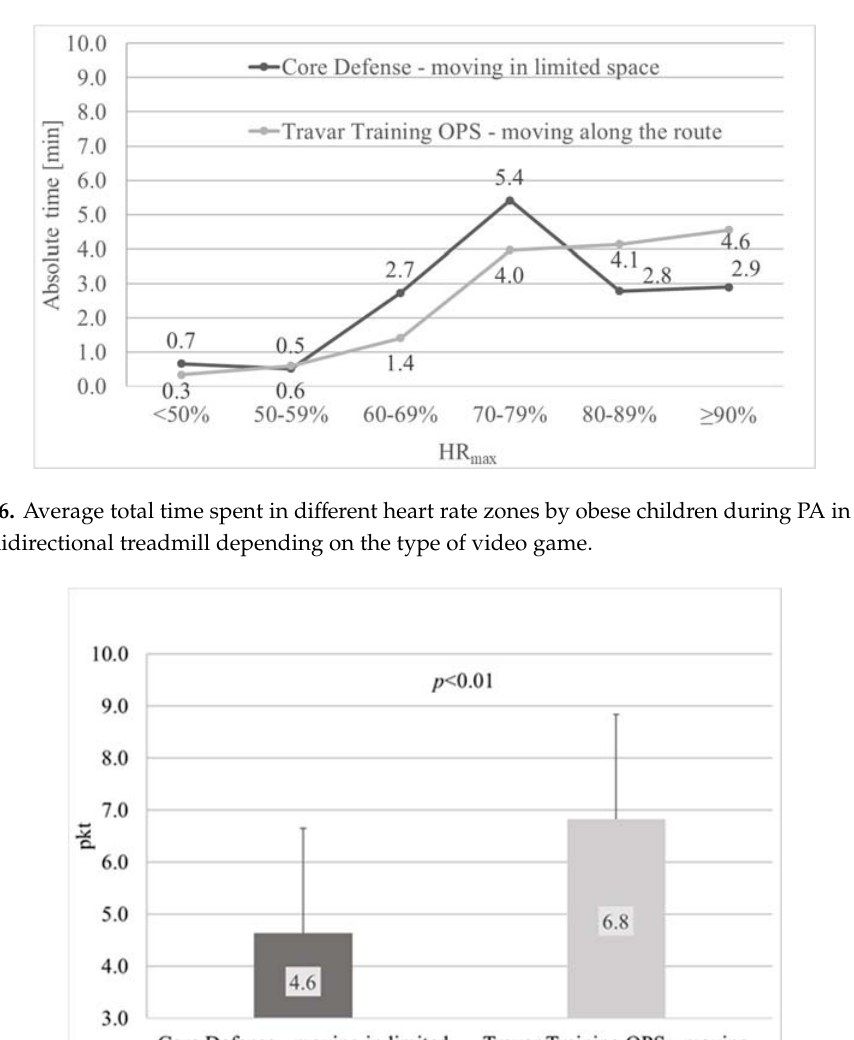
Figure 5. Average intensity of PA of obese children during PA in IVR on an omnidirectional treadmill depending on the type of video game.